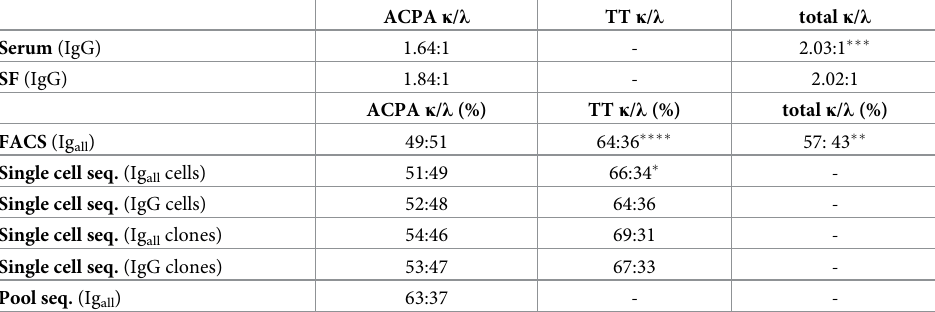
Single cell seq. (Ig all cells) Single cell seq. (IgG cells) Single cell seq. (Ig all clones) Single cell seq. (IgG clones) Pool seq. (Ig all ) Statistical tests resulting in significant differences between ACPA and TT data or ACPA and total IgG/total CD19 + CD20 + B cells data are depicted with level of significance in the column of the group to which ACPA was compared. IgG = immunoglobulin